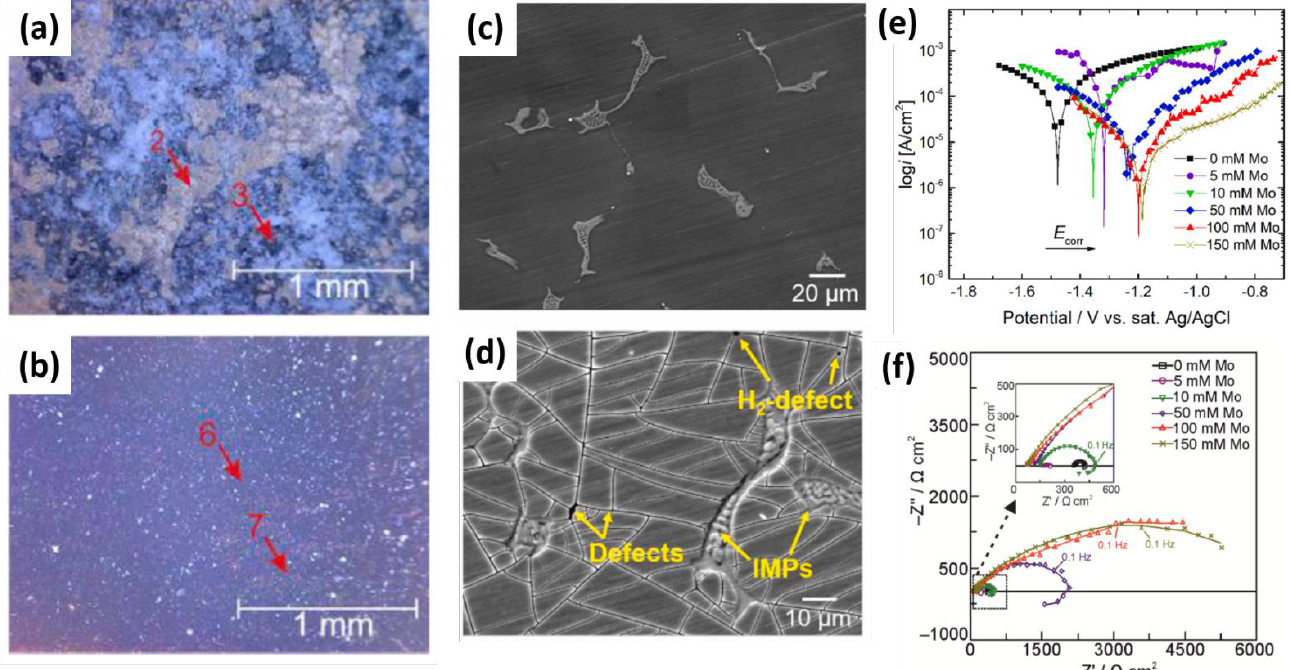
Figure 5. ( a , b ) light microscopy images of the WE43 alloy surface after 24 h exposure to 0.05 M NaCl solution without ( a ) and with ( b ) 100 mM of Na 2 MoO 4 inhibitor. Numbers and arrows indicate the areas of Raman spectroscopy carried out in the corresponding paper [61] ( c ) SEM image of as-polished WE43 surface. ( d ) Surface morphology of the WE43 alloy after 24 h exposure to 0.05 M NaCl solution with 100 mM Na 2 MoO 4 . ( e ) Potentiodynamic polarization curves obtained after 24 h exposure to 0.05 M NaCl without and with molybdate inhibitor. ( f ) Nyquist EIS plots in 0.05 M NaCl solution without and with varying amounts of Na 2 MoO 4 inhibitor after 24 h of exposure. Adapted from [61] with permission from Elsevier.